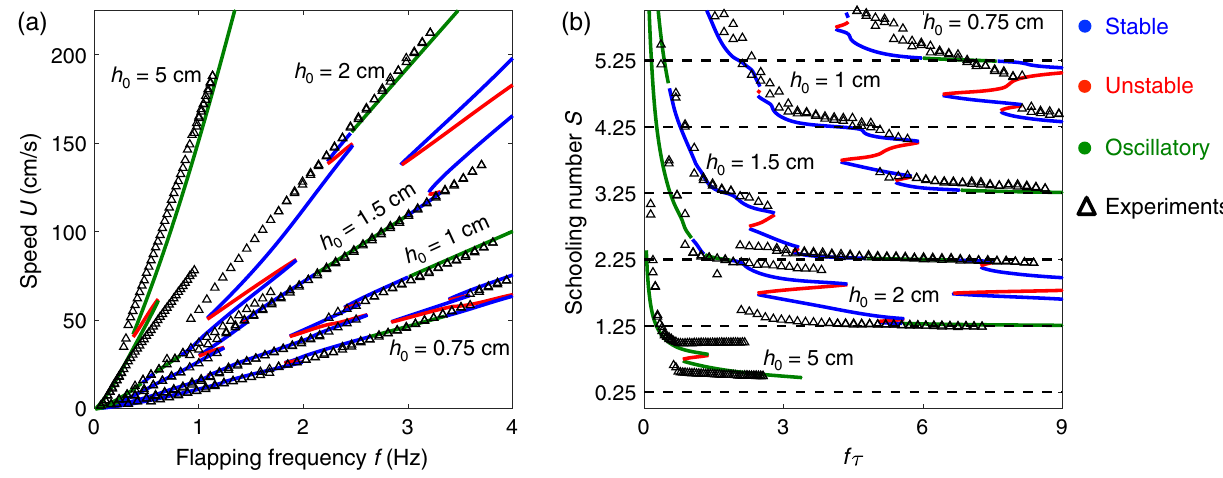
FIG. 2. Model validation. Comparison between the experimental data of Becker et al. [66] (triangles) and the theoretical predictions of Eqs. (2) and (3) (curves). In (a), the formation ’ s speed U is plotted as a function of the flapping frequency f . In (b), the speed U is plotted in terms of the schooling number S ¼ Lf= j U j , and the flapping frequency is made nondimensional by the vortex decay time τ . The theoretically predicted solutions are color coded according to their stability, as outlined in Sec. III: blue indicates stable solutions, red unstable solutions, and green oscillatory